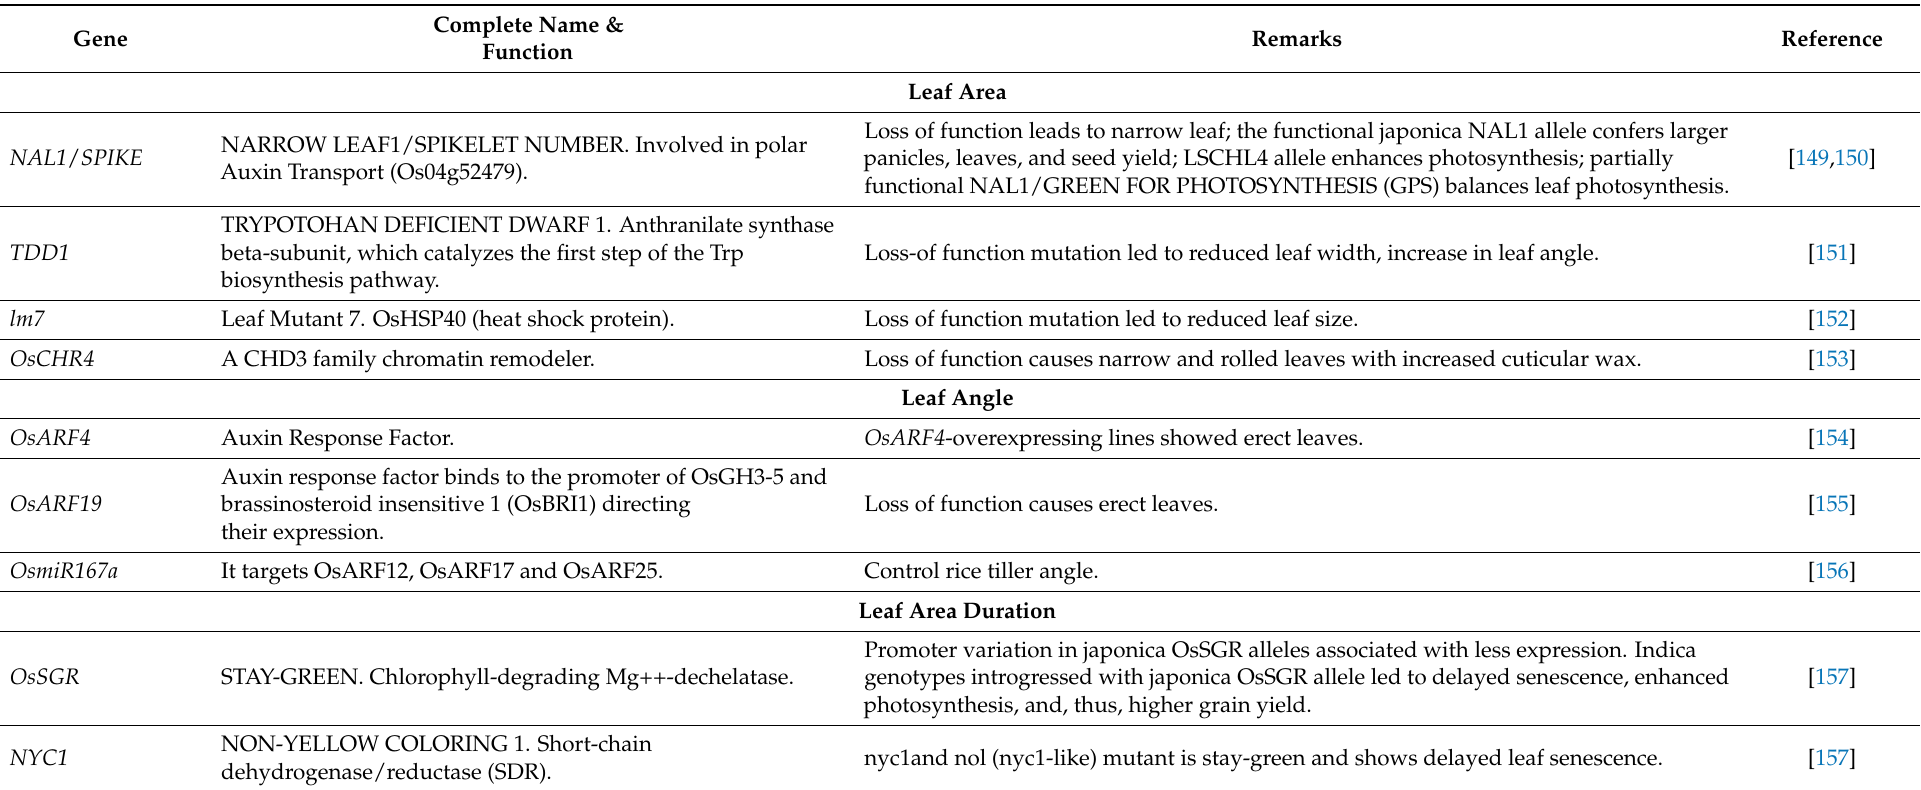
Table 2. Genes/QTLs mapped for source strength, sink strength, and partitioning efficiency in